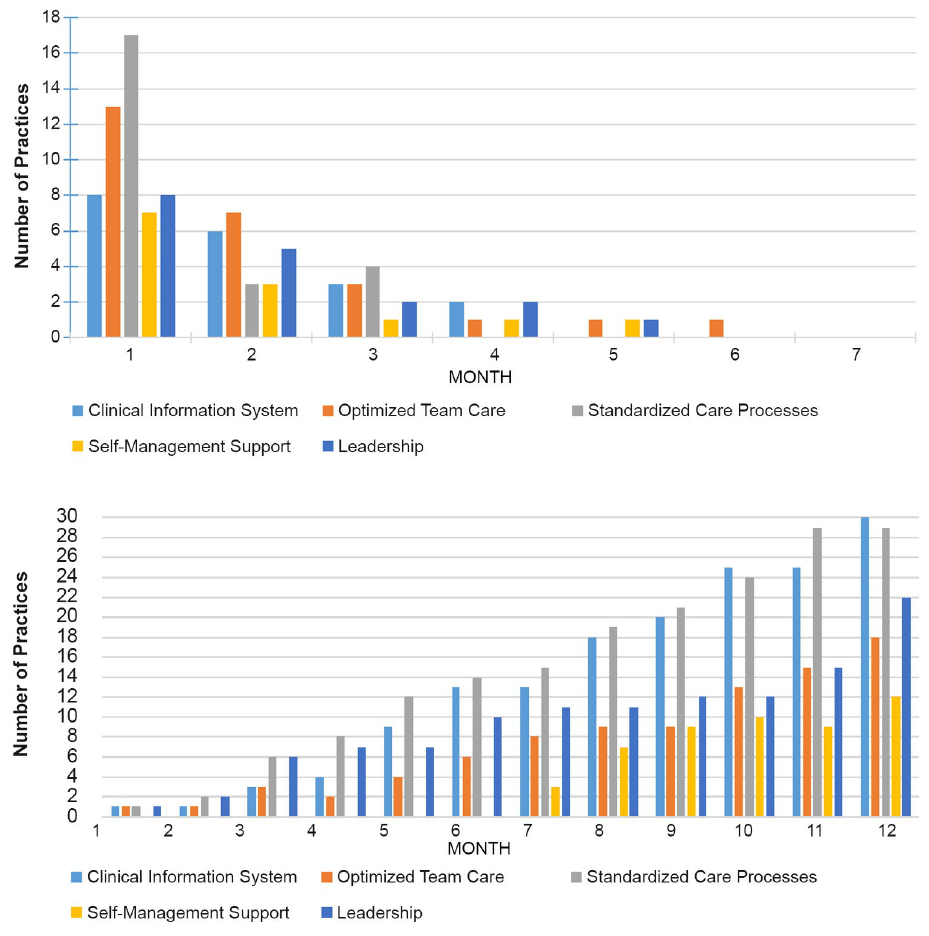
Fig 3. a. Floor Effects by Month. b. Ceiling Effects by